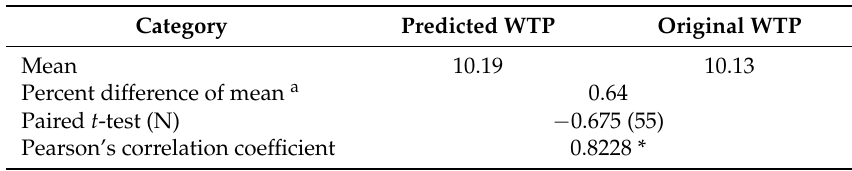
Table 4. Mean, percent difference, paired t -test, and Pearson’s correlation coefficient of the meta-model predicted WTP (willingness to pay) vs. original WTP